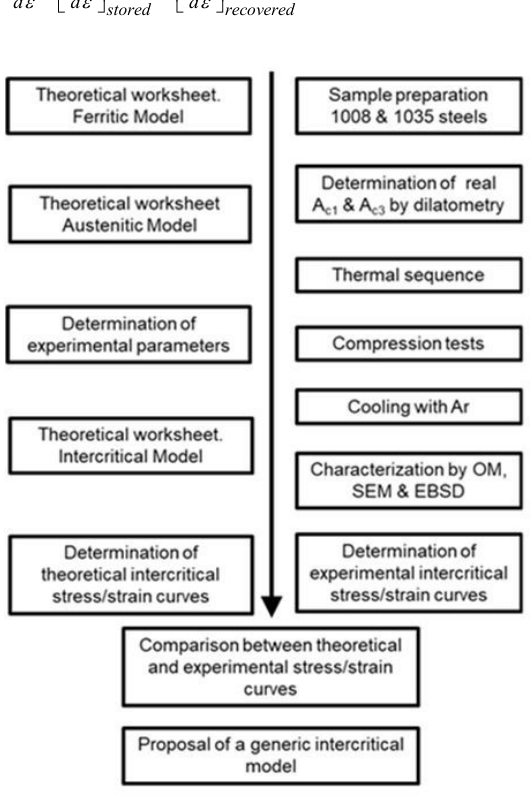
Figure 1. Theoretical and experimental flow